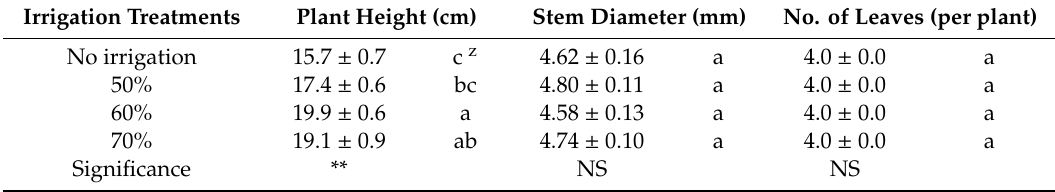
Table 3. Growth of grafted cucumber seedlings as affected by different irrigation regimens during the cultivation of scions and rootstocks in a PFAL ( n = 7).